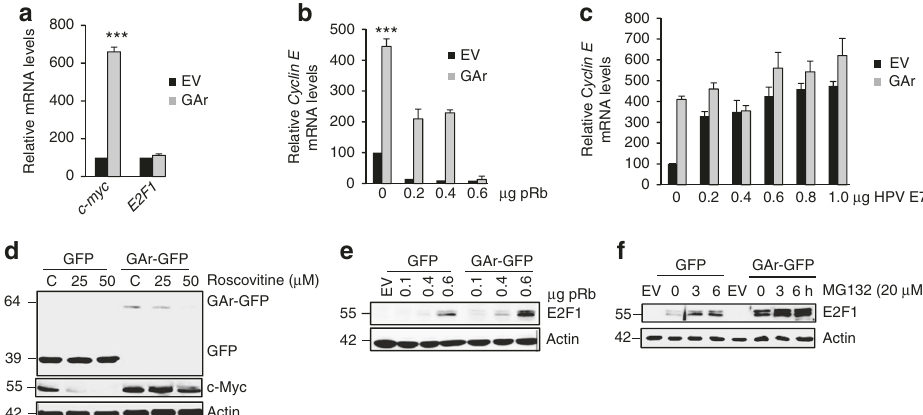
Fig. 3 GAr induces E2F1 protein levels. a RT-qPCR data show the relative levels of c-myc and E2F1 mRNA following GAr expression. b The effect of GAr- induced E2F1 activity as determined by RT-qPCR on Cyclin E mRNA levels following increasing amounts of pRb. c As in b but with increasing amounts of the pRb binding HPV16-E7. d The effect on GAr-mediated induction of c-Myc expression following treatment with increasing concentrations of the cell cycle kinase inhibitor roscovitine. e Western blots showing the levels of E2F1 in cells expressing GFP or GAr-GFP following increasing amounts of pRb. f The levels of E2F1 expression following treatment with the proteasome inhibitor (MG132). The data presented in a , b and c show the means from three independent experiments with s.d. The mRNA levels were normalised against GAPDH and the reference value 100 was set for non-transfected cells. Statistical signi fi cance was calculated using t tests (*** p < 0.001). Western blots represent n ≥ 3 and actin was used as a loading